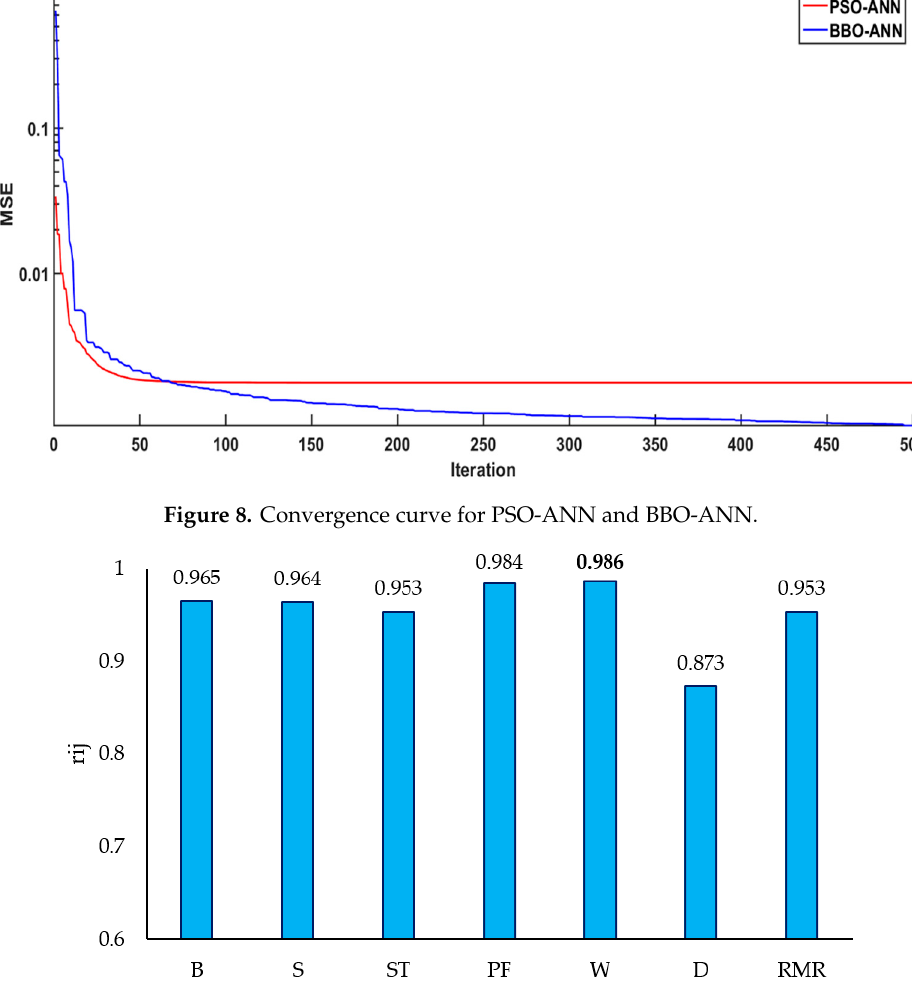
Figure 7. ROC plot displaying the accuracy versus deviation for predicted PPV values on the training and testing dataset using the predictive models.